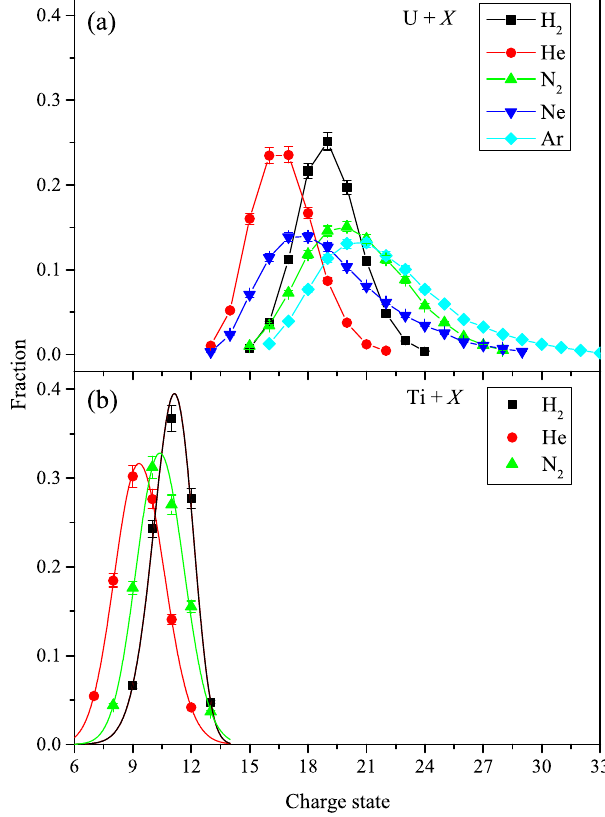
FIG. 10. Saturated charge state distributions for 238 U on H 2 , He, N 2 , Ne, and Ar gas (a) and 50 Ti on H 2 , He, and N 2 gas (b) at 0 . 74 MeV = u beam